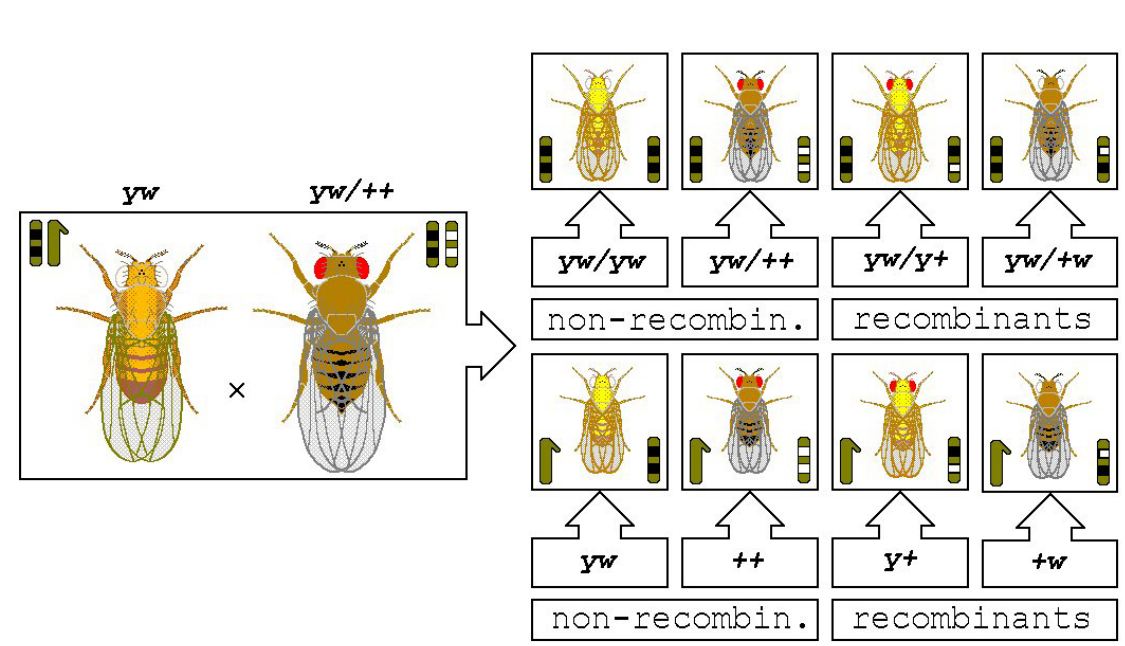
Figure 3 - Non-independent assortment of two X-linked mutant recessive characters (details in the text